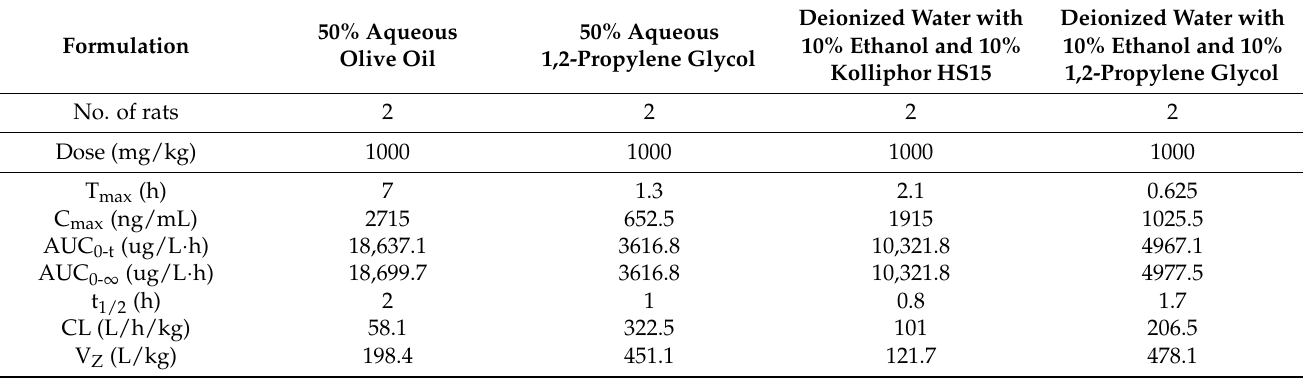
Table 1. Main pharmacokinetic parameters of curcumol with different solvents in rats by oral